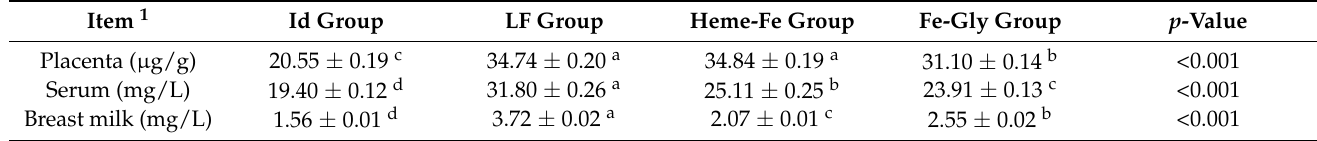
Table 4. Effects of different iron additives on iron content in sow.